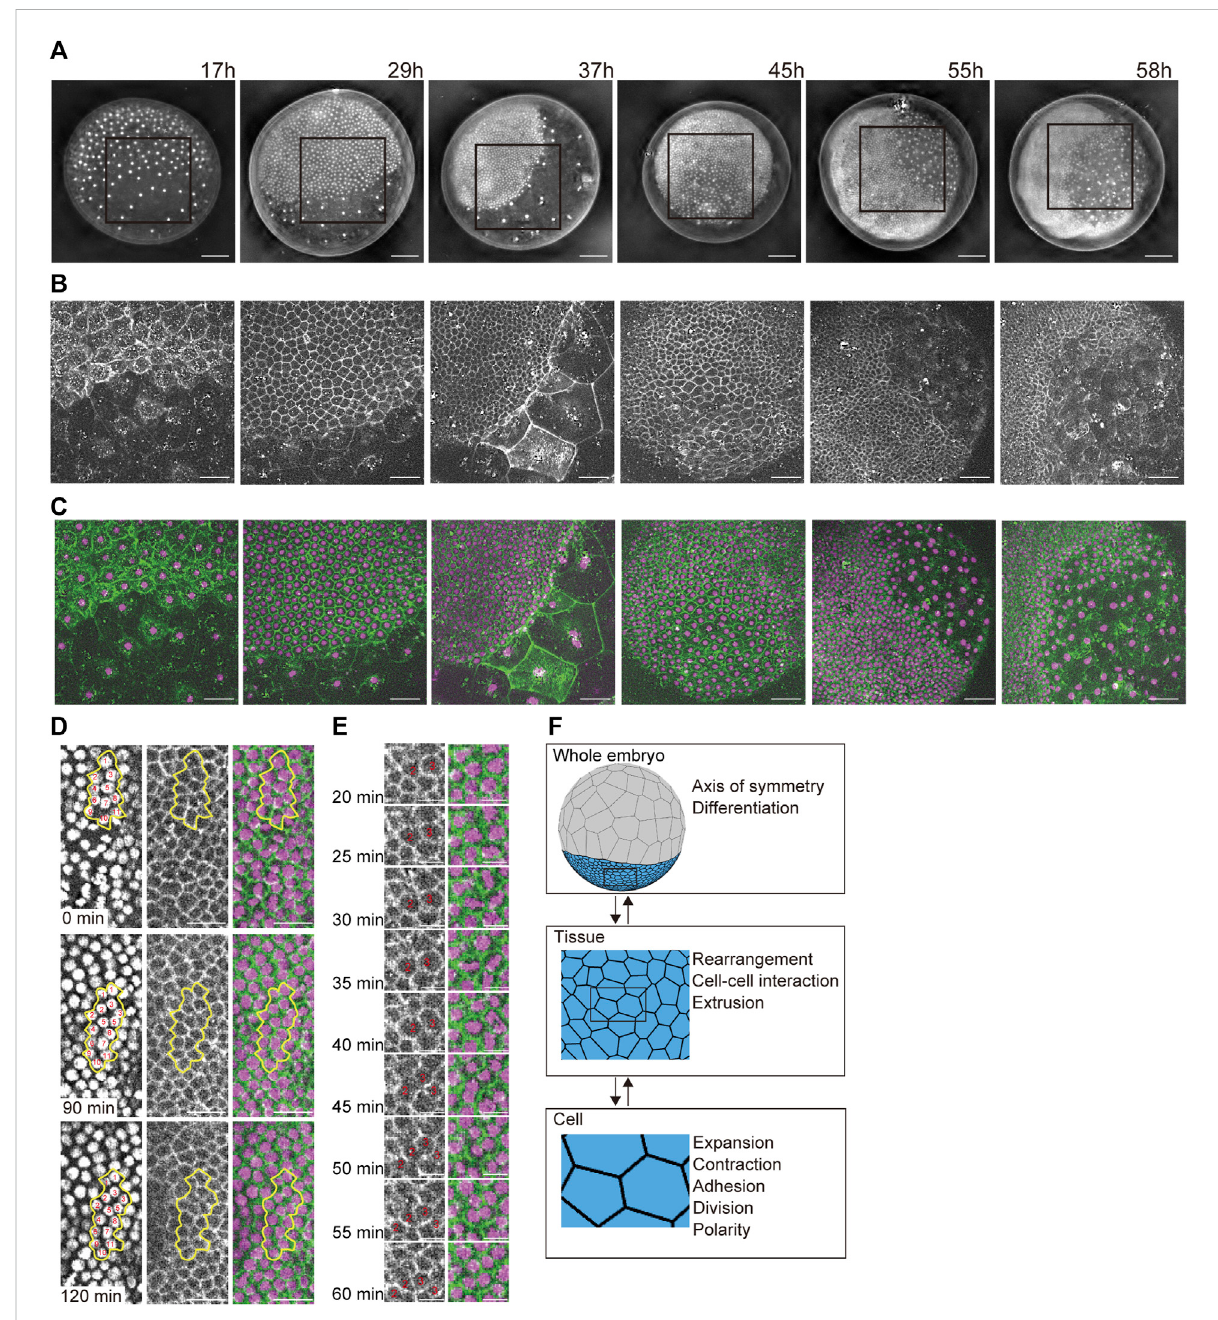
FIGURE 1 Developing multicellular architecture of the P. tepidariorum embryo. (A – C) Extended depth-of- fi eld images of whole embryos at different developmental stages in which DNA [ (A,C) in magenta] and F-actin [ (B,C) in green] are labeled with vital fl uorescent dyes. Time after egg laying (AEL) isindicated.Foreachembryo,theregion boxedin (A) ismagni fi edin (B,C) . (D,E) Time-lapse images ofmediolaterallyorientedcellintercalations and variouslyorientedcelldivisionsinthefuturethoracicregionoftheectoderminaliveembryolabeledforDNAandF-actin. In (D) ,individualcells grouped together outlined with yellow lines are numbered to aid tracking. In (E) , cell divisions are highlighted at higher temporal resolution. See Supplementary Movie S2 for details. Scale bars = 100 μ m in (A) , 50 μ m in (B,C) , 25 μ m in (D) , and 10 μ m in (E) . (F) Schematics of three hierarchical layers in our mathematical modeling of a spider embryo-like multicellular assembly and the phenomena/properties assigned to each layer. See Supplementary Movie S1 for